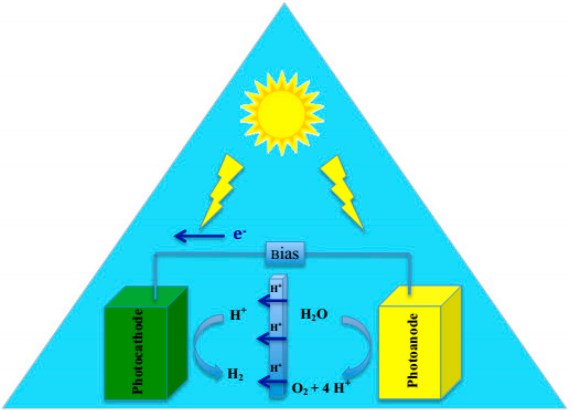
Figure 2. Schematic representation of photoelectrochemical water splitting, Figure adapted from reference [90] of Currao work.